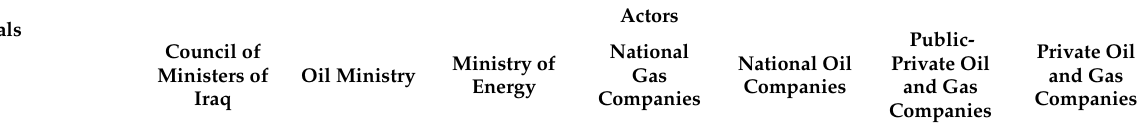
Table 4. Results of the estimation of the importance of actors’